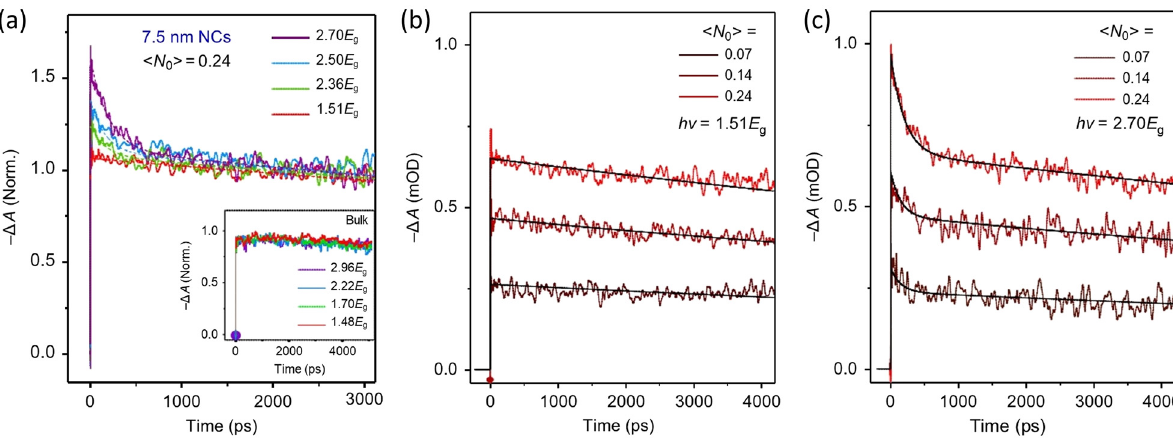
Figure 2: (a) Band-side bleaching kinetics at different pump photon energies in FAPbI 3 nanocrystals. The illustration shows the bulk sample measurements. TA dynamics at the pump energies of (b) 1.51 Eg and (c) 2.70 Eg. The solid black line is a single exponent in (b) and a double exponential fi tting in (c), respectively [46].